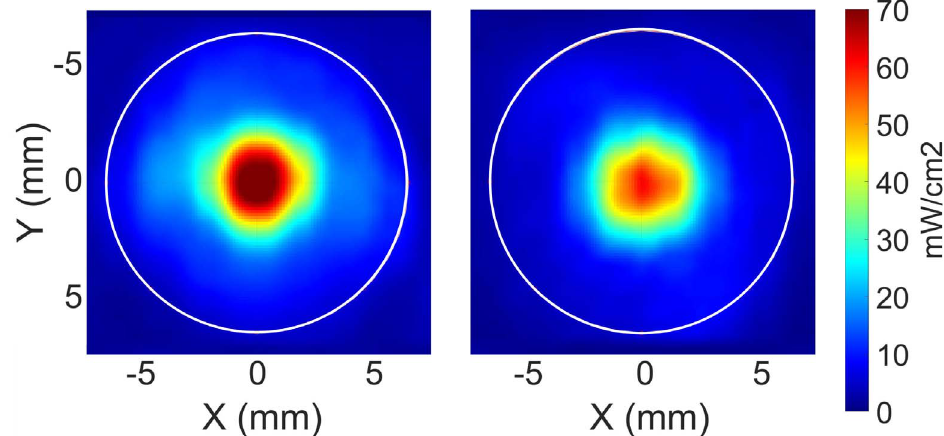
Figure 6. Temporal-average intensity I TA [mW/cm 2 ] distribution without (left – Fig. 3a) and with (right – Fig. 3b) the Petri dish for 1 MHz-transducer at z f = 28 mm. The white circle represents the area of the transducer.